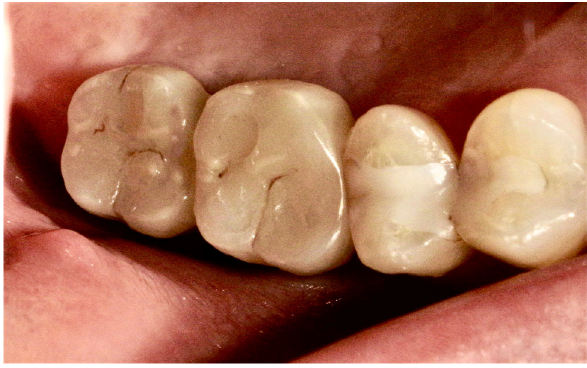
Figure 10. Crowns on implants.